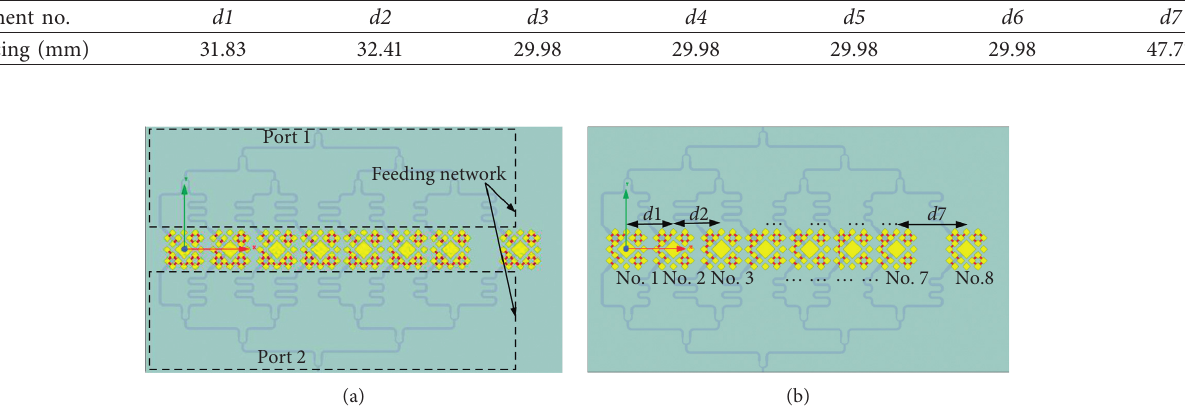
Figure 8: The schematic of the 1 × 8 linear array with feeding network. (a) θ xoz � 25 ° . (b) θ xoz � 45 ° .